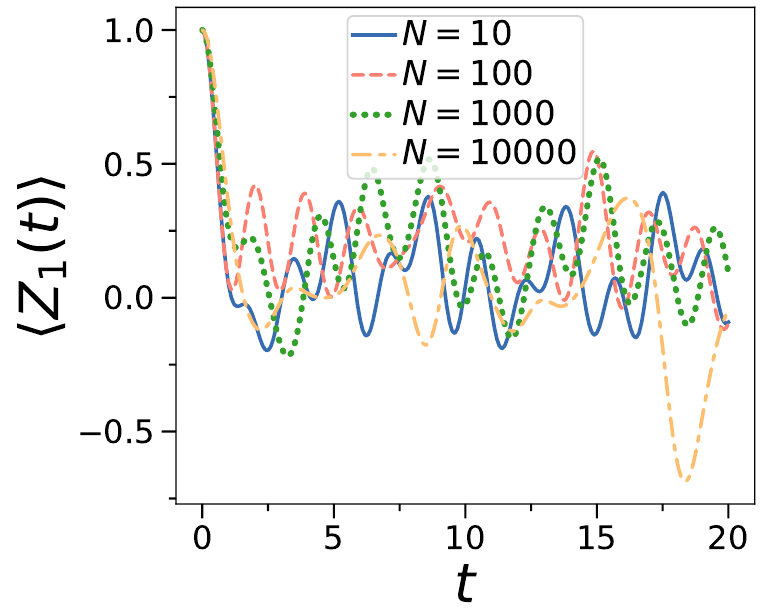
Figure 6: Dynamics of Hamiltonians consisting of multi-body Pauli strings for varying number of qubits N . Hamiltonians are composed of r different random Pauli strings (cid:80) r H = P , where the Pauli strings P i i = 1 ∈ { I , X , Y , Z } . The initial state | ψ 〉 = | 0 〉 ⊗ N is the N -qubit product state with tors σ j all zeros. The cumulative K -moment states consists of 2 r = 128 ansatz states and exactly captures the full